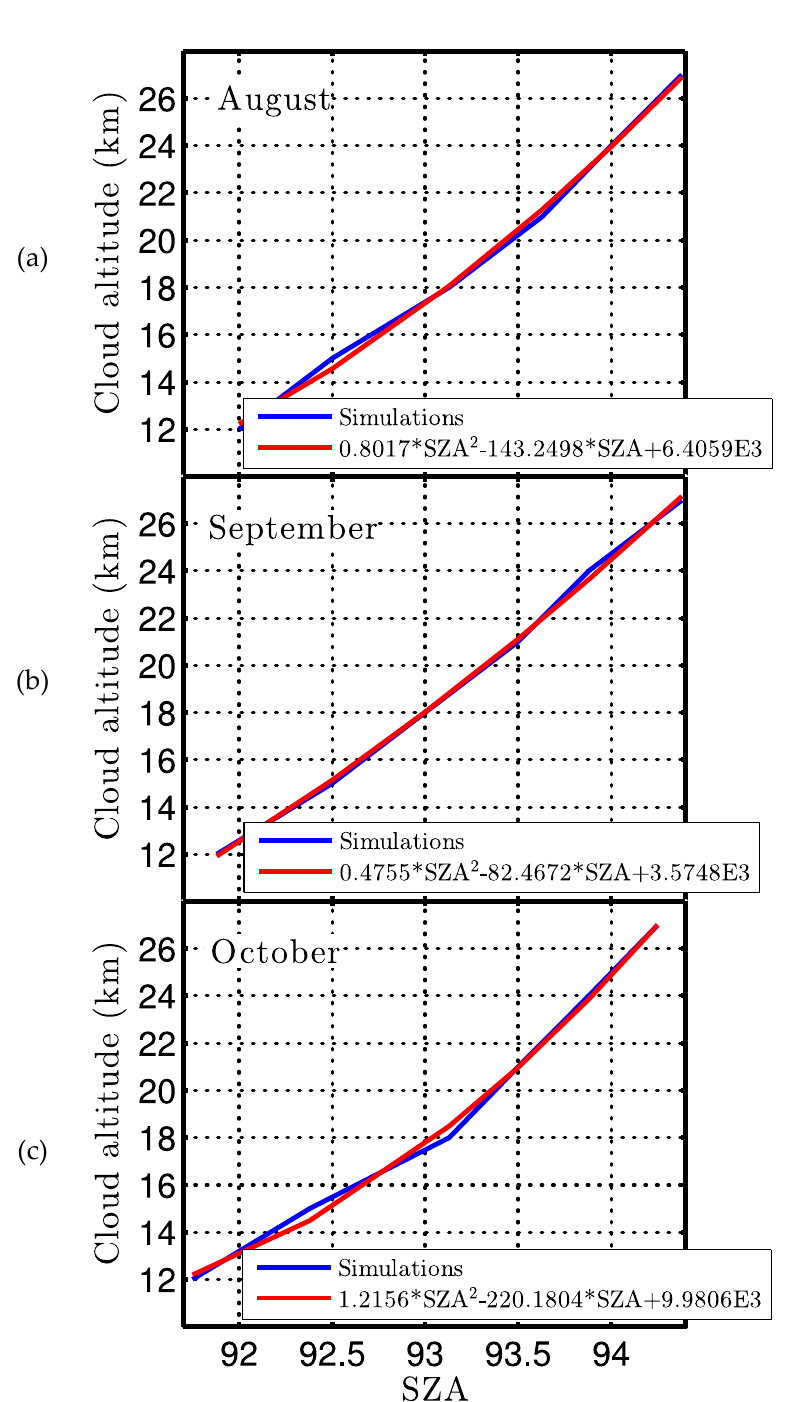
Figure 5. Polar Stratospheric Clouds (PSC) altitude vs solar zenith angles (SZA) of maximum color index (CI) from simulations (blue) and its corresponding polynomial fitting (red), for the months of August ( a ), September ( b ) and October ( c ). The curves were computed for a PSC cloud opacity τ PSC = 0.2, no tropospheric clouds and the gas profiles illustrated in Figure 4.